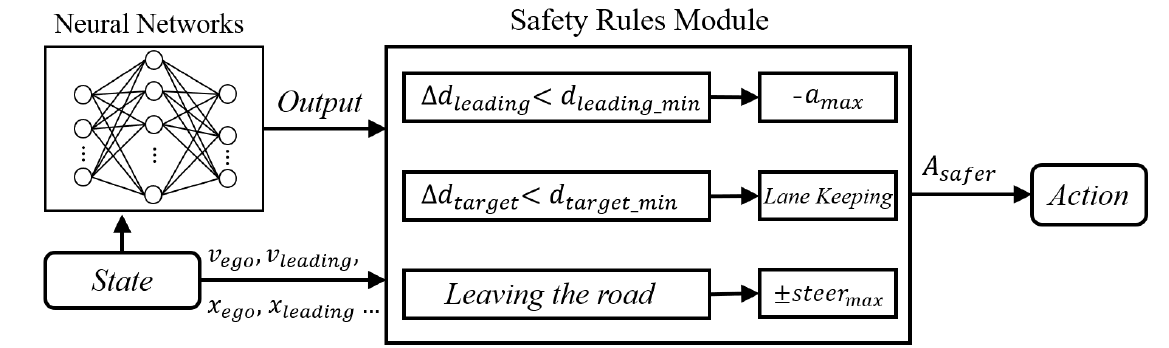
Figure 6. Safety Rules module.